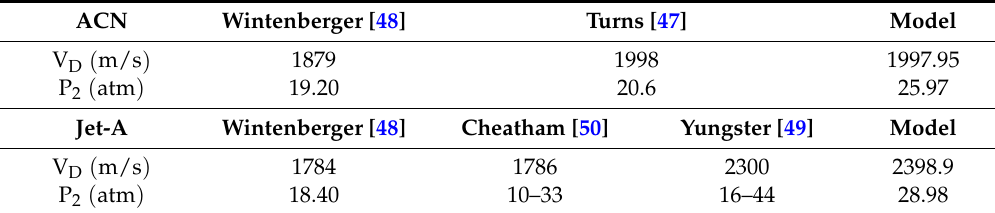
Table 2. Validation of the model with analytical and experimental